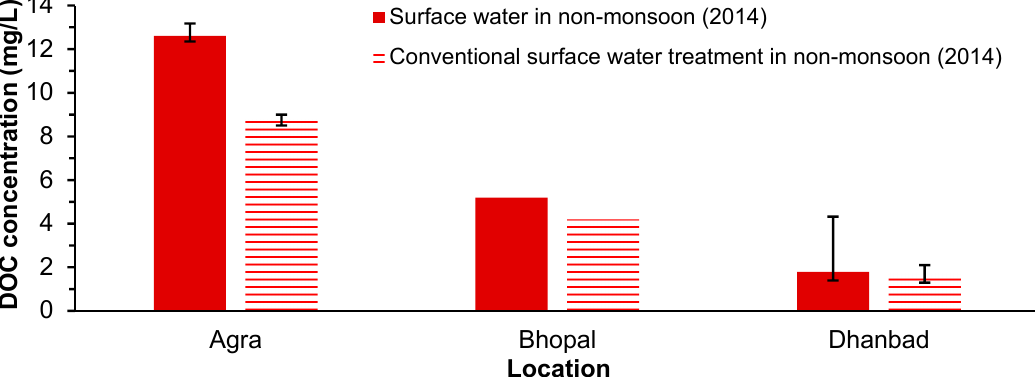
Figure 3. Median DOC concentrations in surface water and conventionally treated drinking water derived from direct surface water abstraction at selected sites in non-monsoon 2014. Error bars indicate the standard deviation for number of samples ( n ) ≥ 2. Agra: Yamuna, n = 3, n CT = 2; Bhopal: Upper Lake, n = 1, n CT = 1; Dhanbad: Damodar, n = 3, n CT = 2.